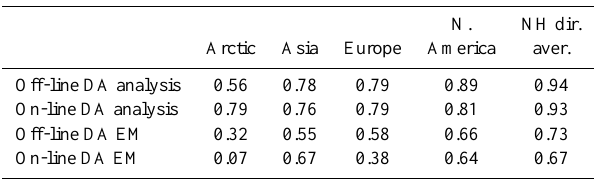
Table 2. Northern Hemisphere correlations between simulations and proxy-based reconstructions for the analysis and the ensemble mean of the two data assimilation